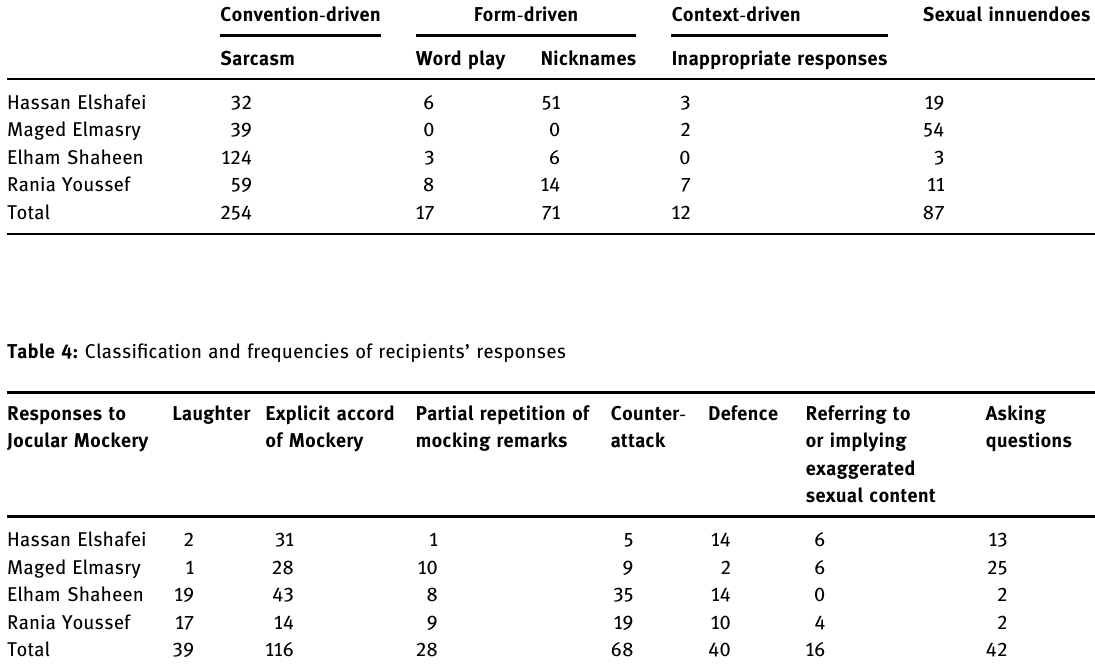
Table 3: Frequencies of implicational impoliteness events Impoliteness events